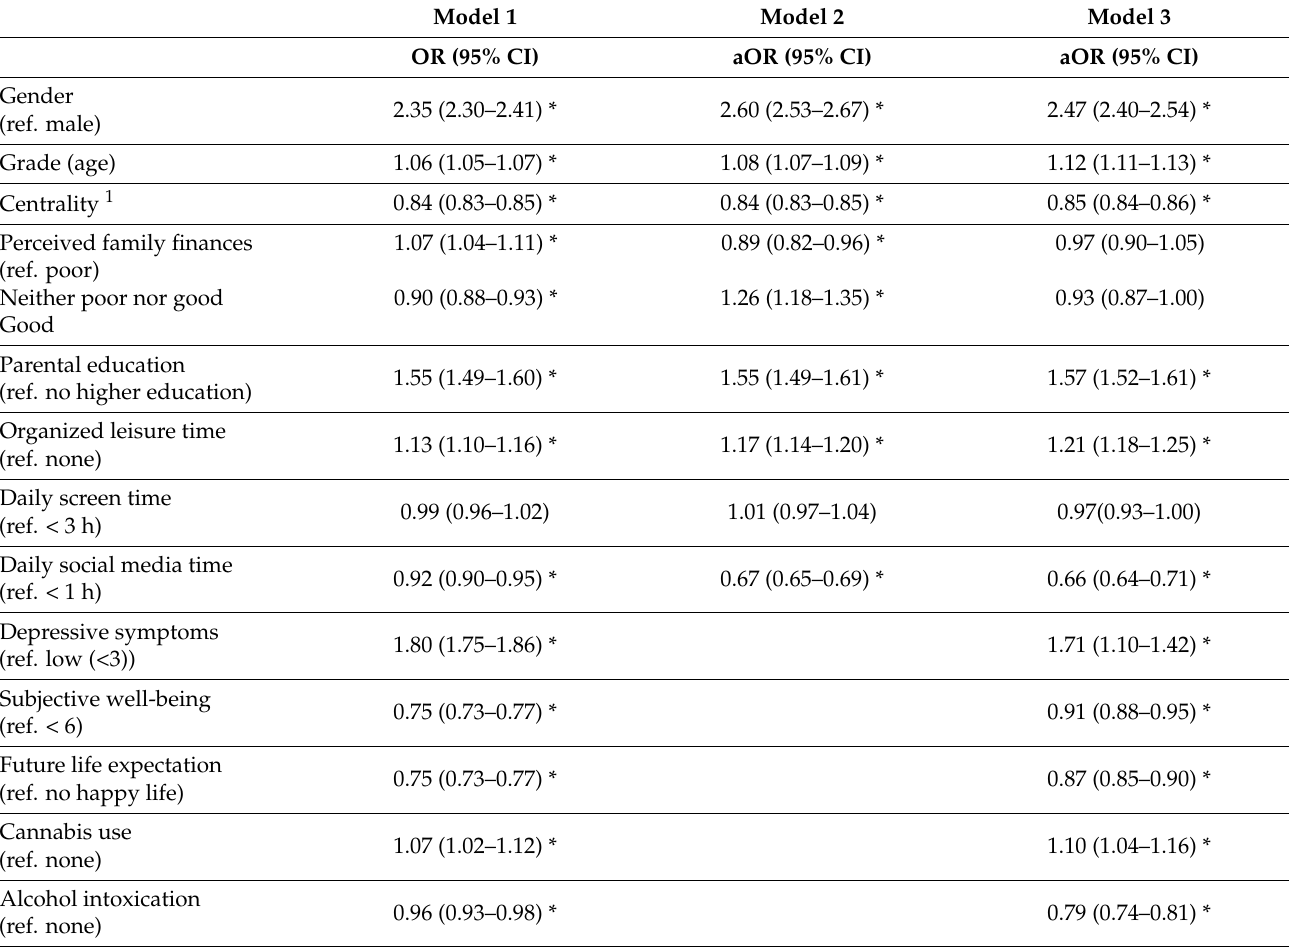
Model 1: Crude Odds Ratio (OR); Model 2: Adjusted for sociodemographics and leisure activities; Cox and Snell R 2 : 0.07, Nagelkerke R 2 : 0.09; Model 3: Adjusted for sociodemographics, leisure activities, mental health, cannabis use and alcohol intoxication; Cox and Snell R 2 : 0.07, Nagelkerke R 2 : 0.10; 1 Higher is less central, * p <